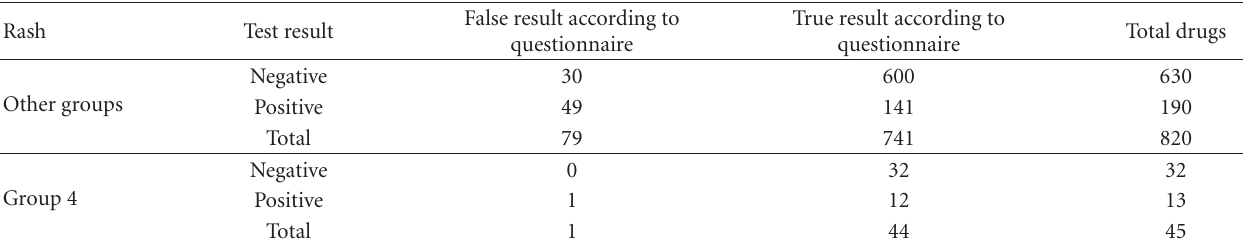
Table 5: Correlation between vasculitis patients (group 4) in comparison to other patients and IFN-gamma release results for all